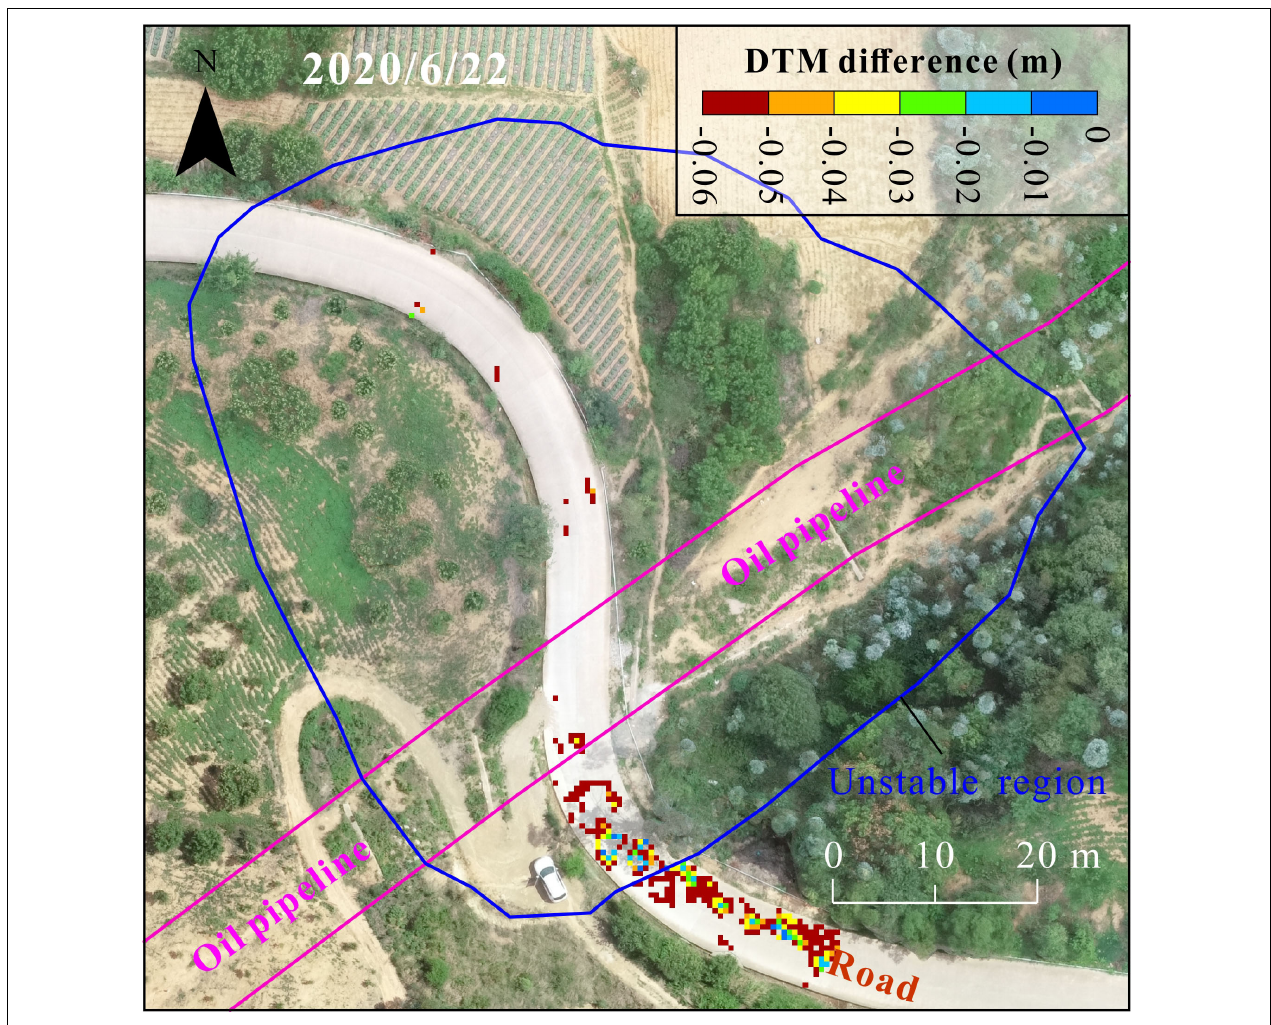
FIGURE 14 | Vertical and horizontal displacement